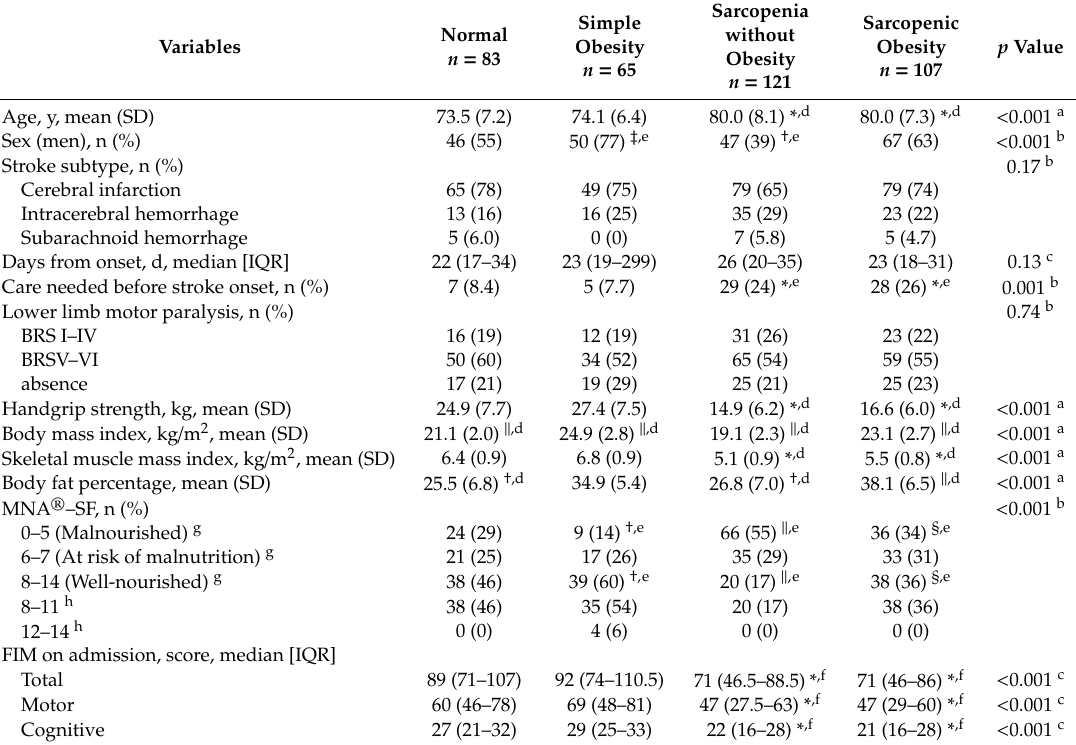
Table 1. Characteristics of patients with stroke in convalescent rehabilitation wards and between-group comparison according to the presence of obesity and / or